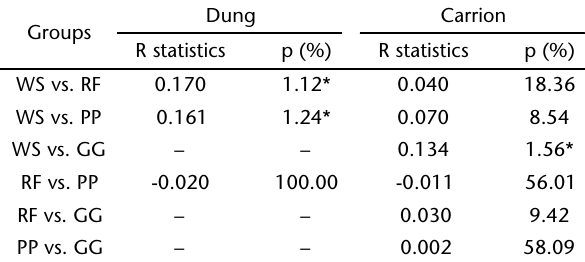
Table III. ANOSIM. Pairwise comparison of Drosophila species abundance and composition between habitats for dung (D) and carrion (C) baited pitfall